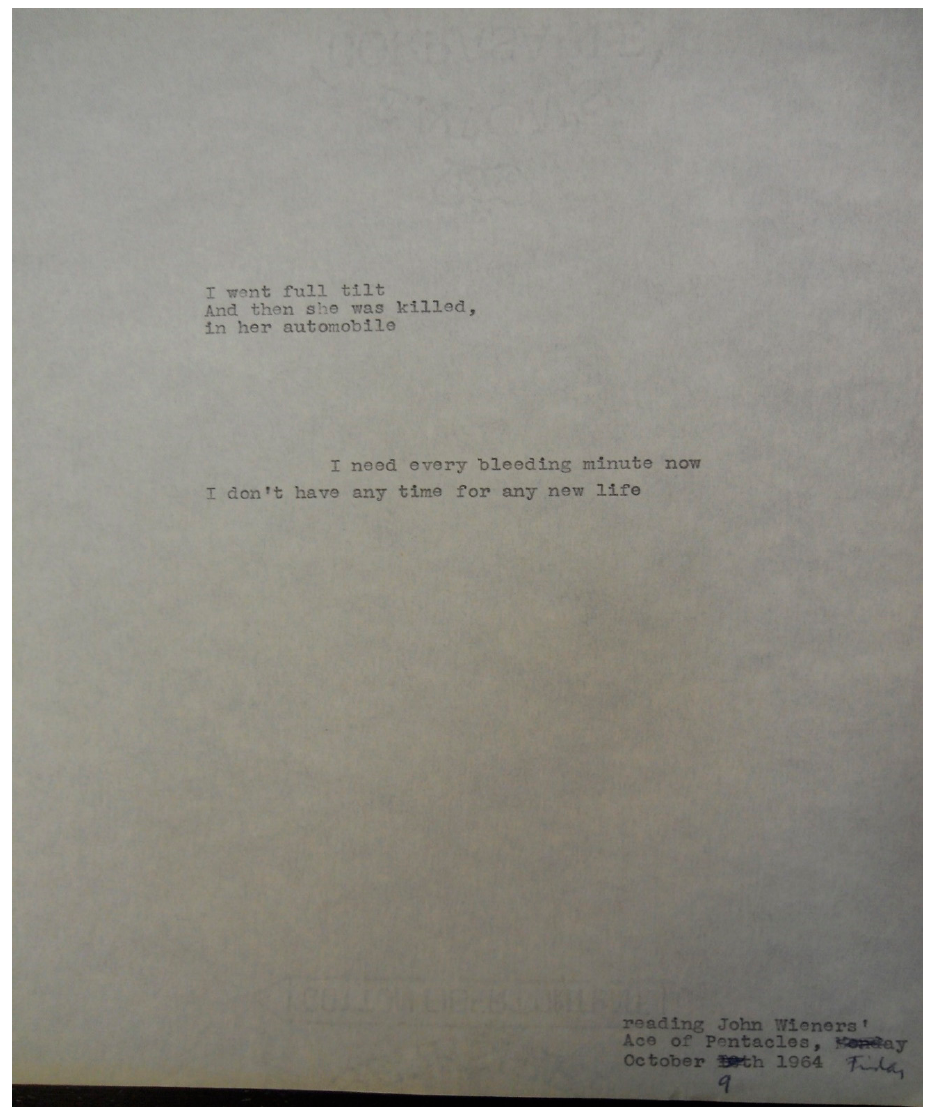
Figure 1. “I went full tilt …”, box 24, folder 1149, Charles Olson Research Collection. Archives and